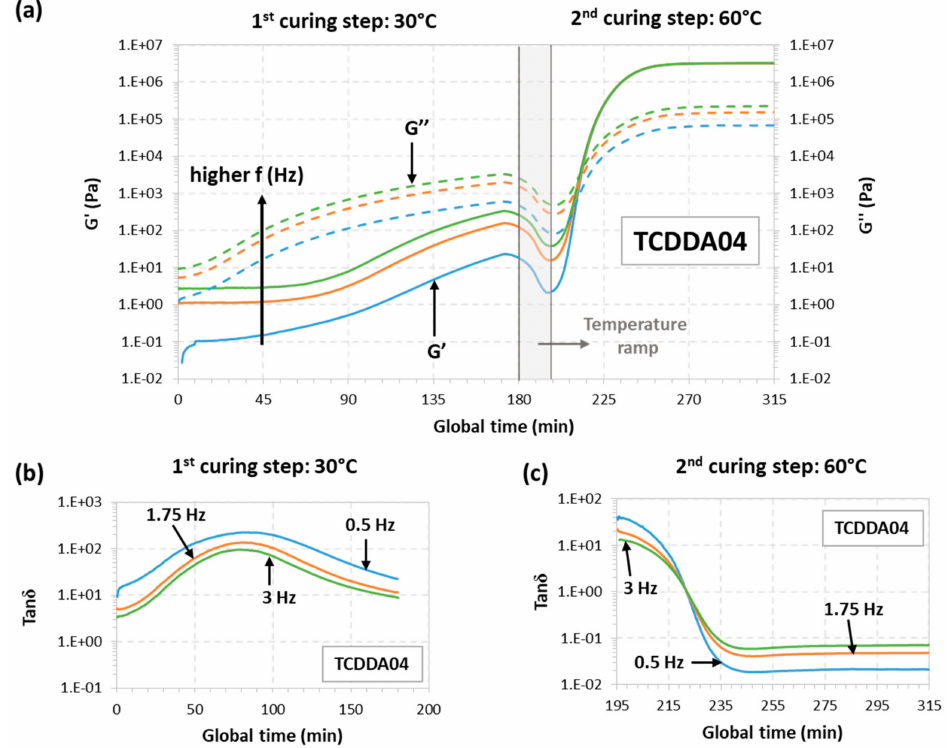
Figure 2. Rheological analysis of TCDDA04 dual-curing procedure: ( a ) Storage modulus ( G (cid:48) ) and loss modulus ( G ”) evolution with time during the whole dual-curing process; ( b ) evolution of tan δ with time during the 1st curing stage and ( c ) evolution of tan δ during the 2nd curing